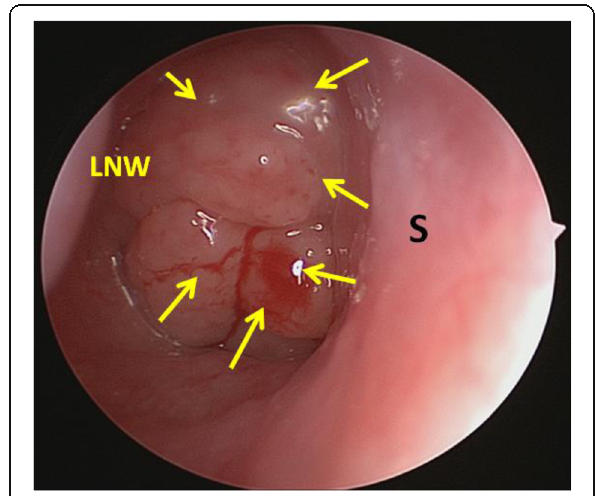
Fig. 1 Preoperative transnasal endoscopy examination demonstrating enlarged adenoids obstructing RT choana (arrows) [LNW, lateral nasal wall; S, nasal